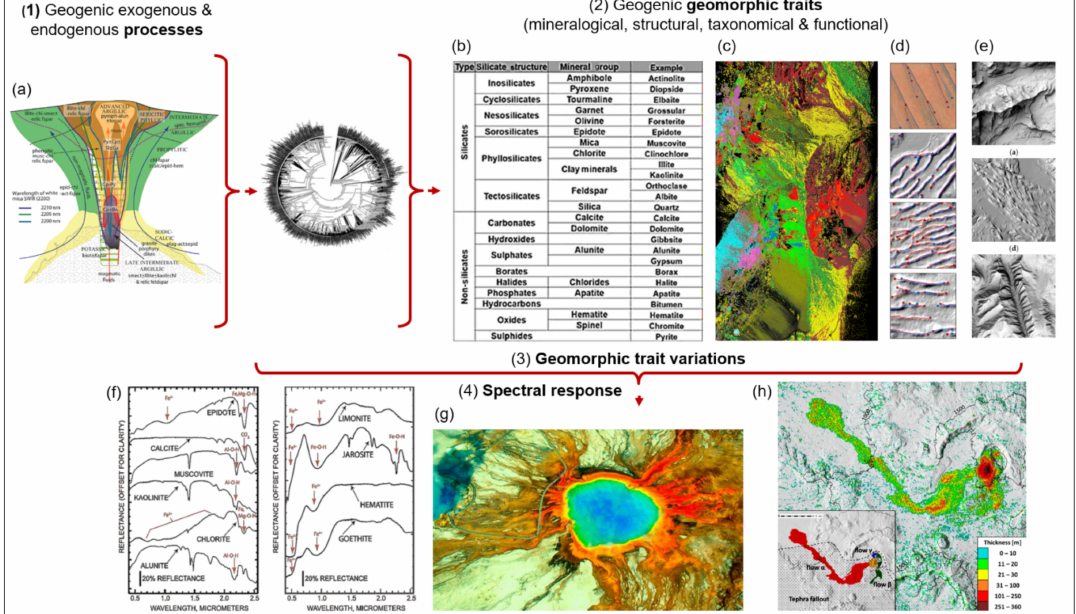
Figure 11. (1) Geogenic exogenous and endogenous processes, such as in such as a volcanic eruption ( a ) leads to characteristic geogenic geomorphic traits. (2) Geomorphic traits can be: mineralogical, structural, taxonomic and functional traits, such as: ( b , c ) different minerals, ( d ) different sturcural forms and form complexes, ( e ) different rock types. Consequently, the processes, e.g., volcanic erup- tions lead to (3) geomorphic trait variations and the shaping of terrain and mountains. Geomorphic traits and trait variations produce a morphologogically specific (4) spectral response, which can be detected using different RS technologies. ( f ) Laboratory spectral features of different hydrothermal minerals and mapping results from RS analysis are crucial for mineral classification, ( c ) VNIR-AVIRIS hyperspectral data from the Cuprite area (Nevada) show results of lithography classification us- ing hyperspectral RS data, ( g ) Representation of a volcanic eruption using RS of the Siberian Trap, ( h ) Distribution of volcanic deposits optained by differencing pre-eruptive and post-eruptive DEMs derived from ASTER and PlanetScope RS Data, location—Nabro volcano; Image sources: ( a , b ) from Peyghambari and Zhang [108], ( c , f ) from Clark et al. [96], ( d ) from Shumak et al., [97], ( e ) from Farmakis-Serebryakova et al. [98], ( h ) reprinted with permission from Calvari et al., [109], 2022, Elsevier. license number: